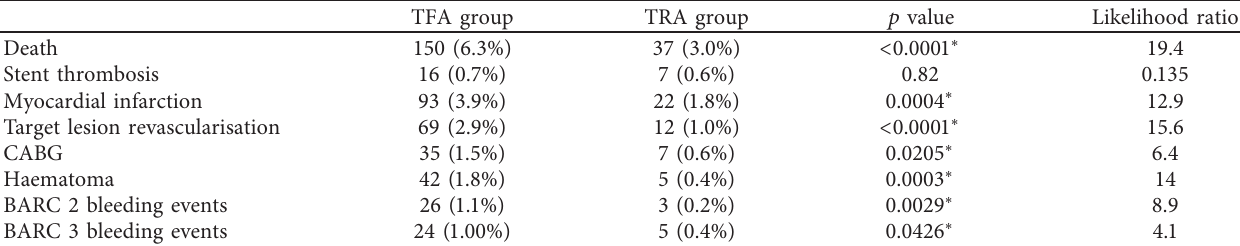
Figure 1: Trends in percutaneous coronary intervention (PCI) access site. TRA � transradial artery access. TFA � transfemoral artery Table 3: Unadjusted analysis of procedural outcomes at 12 months.